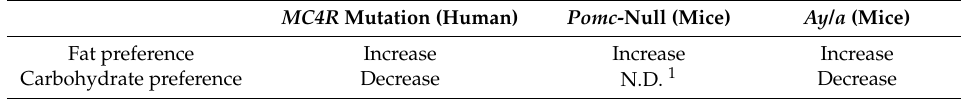
Table 2. Central melanocortin system mutants and macronutrient